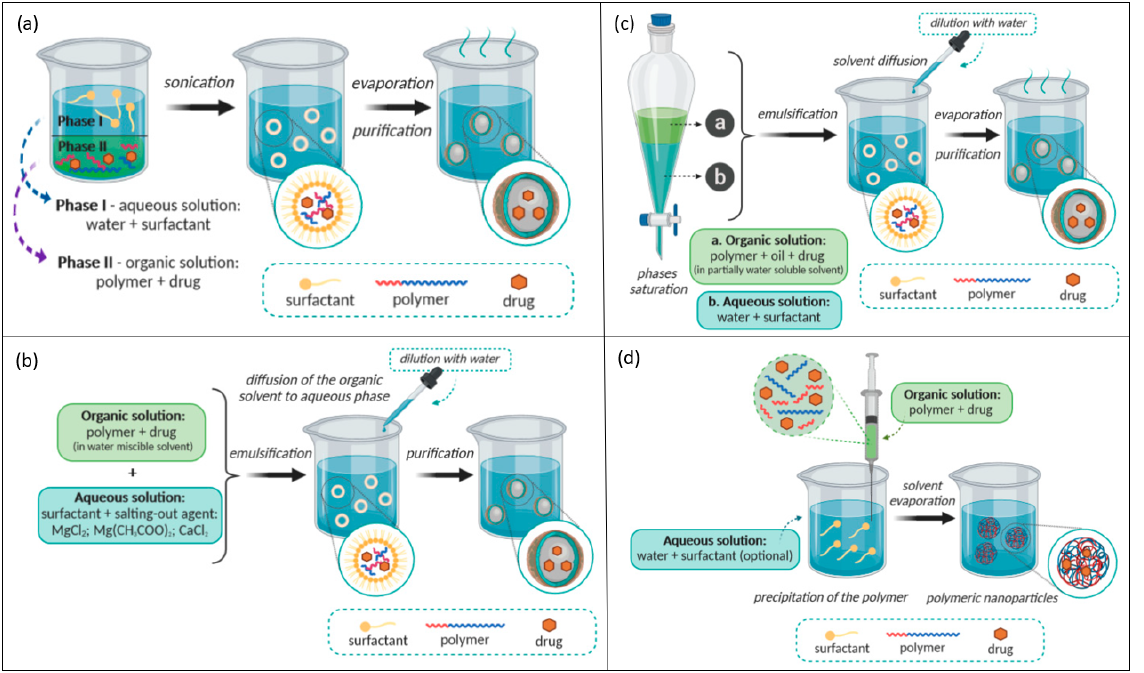
Figure 3. Schematic representation of several polymer nanoparticles synthesis methods: ( a ) solvent evaporation method; ( b ) emulsification/reverse salting-out method; ( c ) emulsification/solvent diffusion method; ( d ) nanoprecipitation method. Reprinted from an open-access source [172].